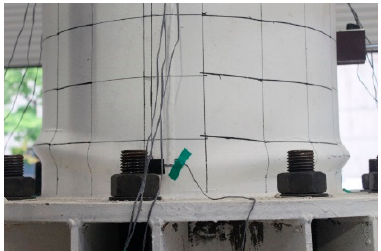
Figure 23. Load–displacement hysteresis curve of SP-0.